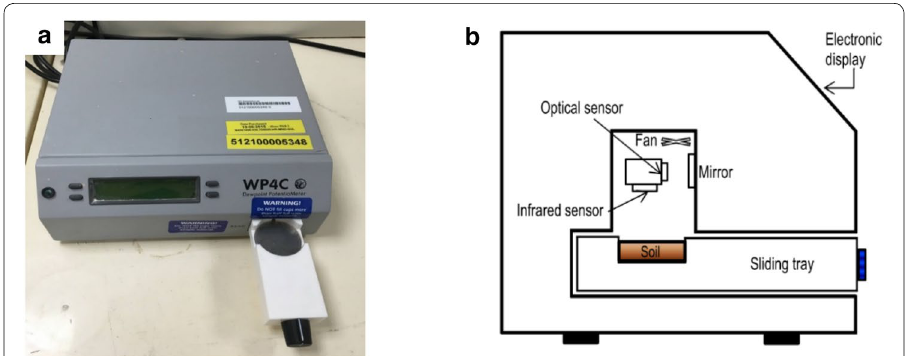
Fig. 6 a Photo of WP4C and b schematic diagram of dew-point potentiometer using